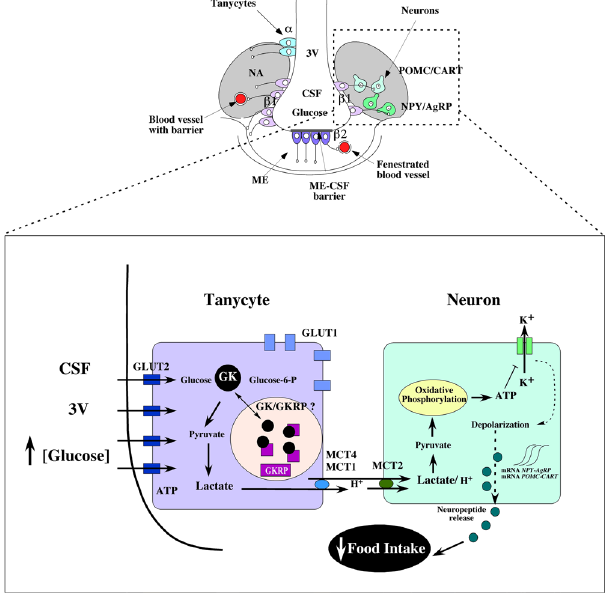
Figure 7. Hypothalamic glucosensing and its inhibition by GK knockdown in tanycytes. Model of glucosensing based on the metabolic interaction between tanycytes and AN neurons. Tanycytes are a specialized ependymal cell, localized in the lower parts of the ventricular walls and the floor of the 3V. α and β 1-tanycytes line the infundibular recess, and their basal projections reach orexigenic and anorexigenic AN neurons. β 2-tanycytes cover the floor of the 3V and extend their projections inside the ME and regulate the permeability properties of the fenestrated capillaries of the ME. Hyperglycemia results in increased glucose concentrations in the 3V, which affects GK-positive β 1-tanycytes. These glial cells sense the increased glucose by the presence of GLUT2 and GK. The GK activity could be regulated by GKRP and its nuclear compartmentalization. Lactate released by tanycytes could activate neurons of AN, generating a satiety response. GK inhibition represses the glucosensing circuit, causing an altered feeding behavior. 3V, third ventricle; ME, median eminence; CSF, cerebrospinal fluid; GK, glucokinase; AN, arcuate nucleus; MCT, monocarboxylate